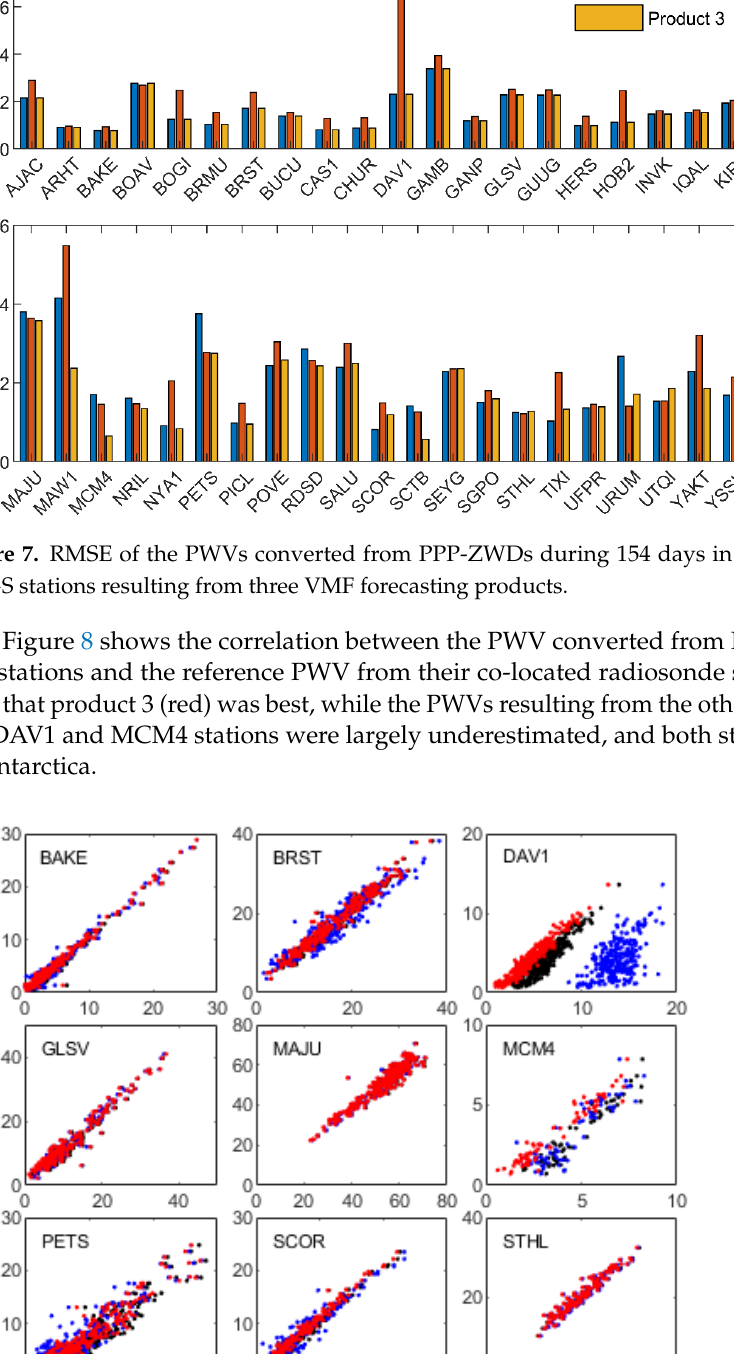
Figure 8. Correlation between the PWV converted from PPP-ZWD of 154 days in 2020 at nine IGS stations resulting from three VMF products (the results of products 1 to 3 are in black, blue, and red, respectively) and the reference PWV from radiosonde data.